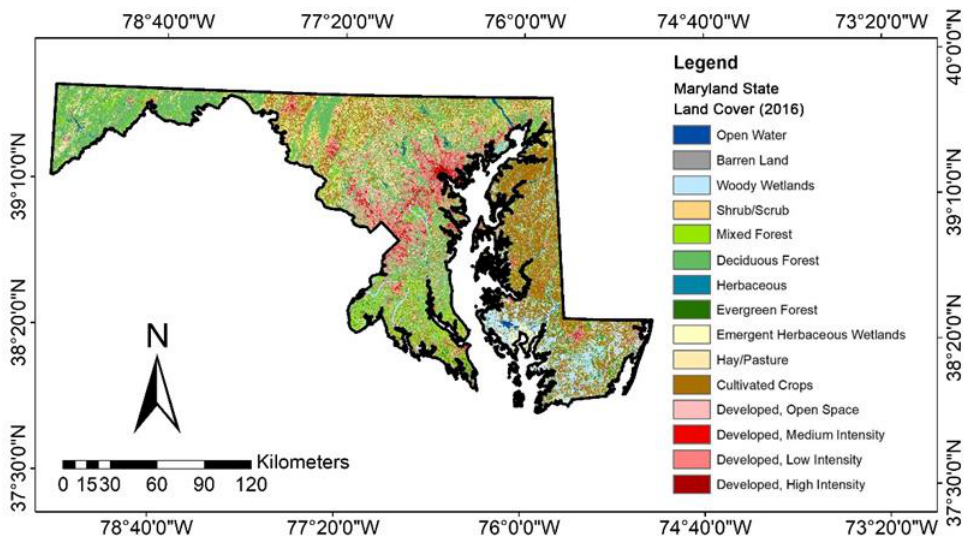
Figure 3. Maryland (USA) land cover map for 2016 ( 37°53′ N to 39°43′ N ; 75°03′ W to 79°29′ W ) (derived from MRLC